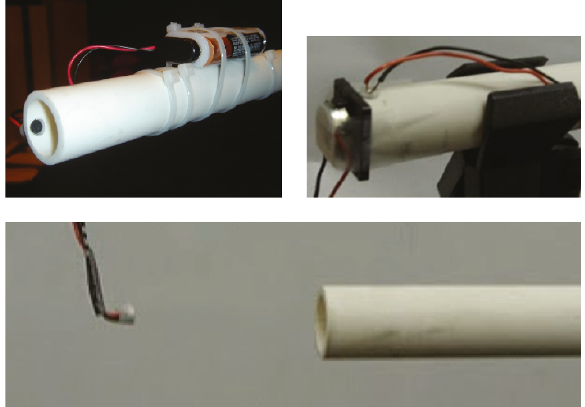
Figure 3: A speaker seals one end of a two-meter long cylindrical tube, with a colocated microphone press fit into the tube wall, flush with the tube’s interior wall. A second microphone is placed 7 cm outside the instrument/tube’s open end, on the tube/bore axis. This setup may be modeled using the signal flow diagram in Figure 4.